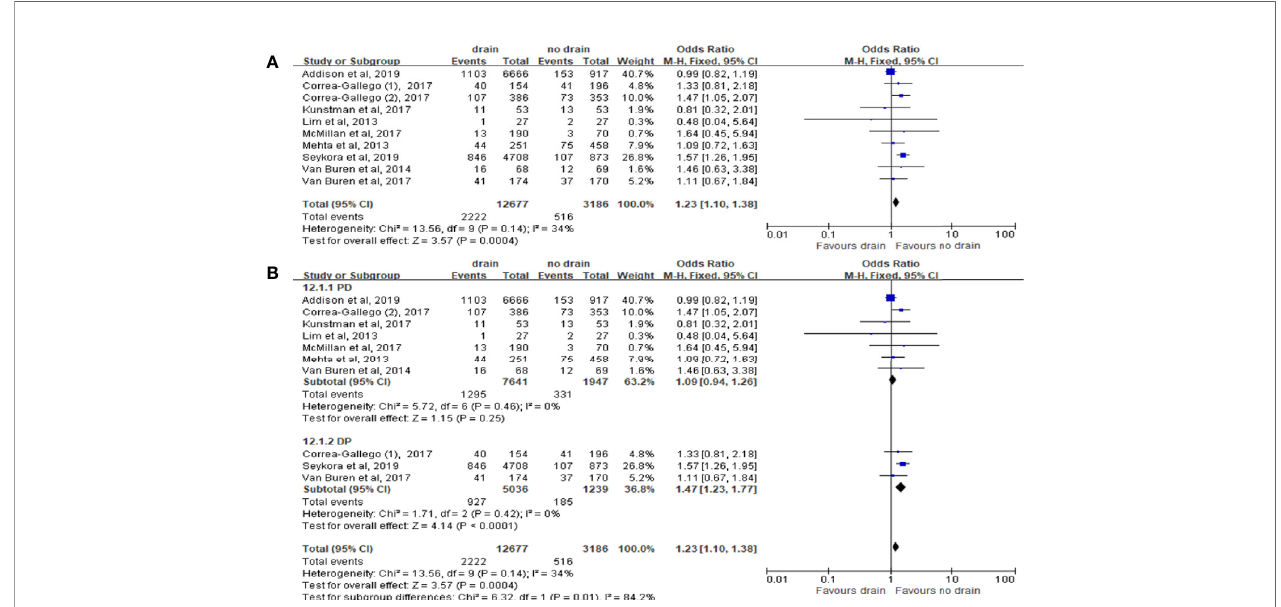
FIGURE 14 | Forest plot of the comparison of the rate of readmission in drain versus no-drain groups after pancreatic resection. (A) Comparison in overall; (B) comparison in PD and DP subgroups,